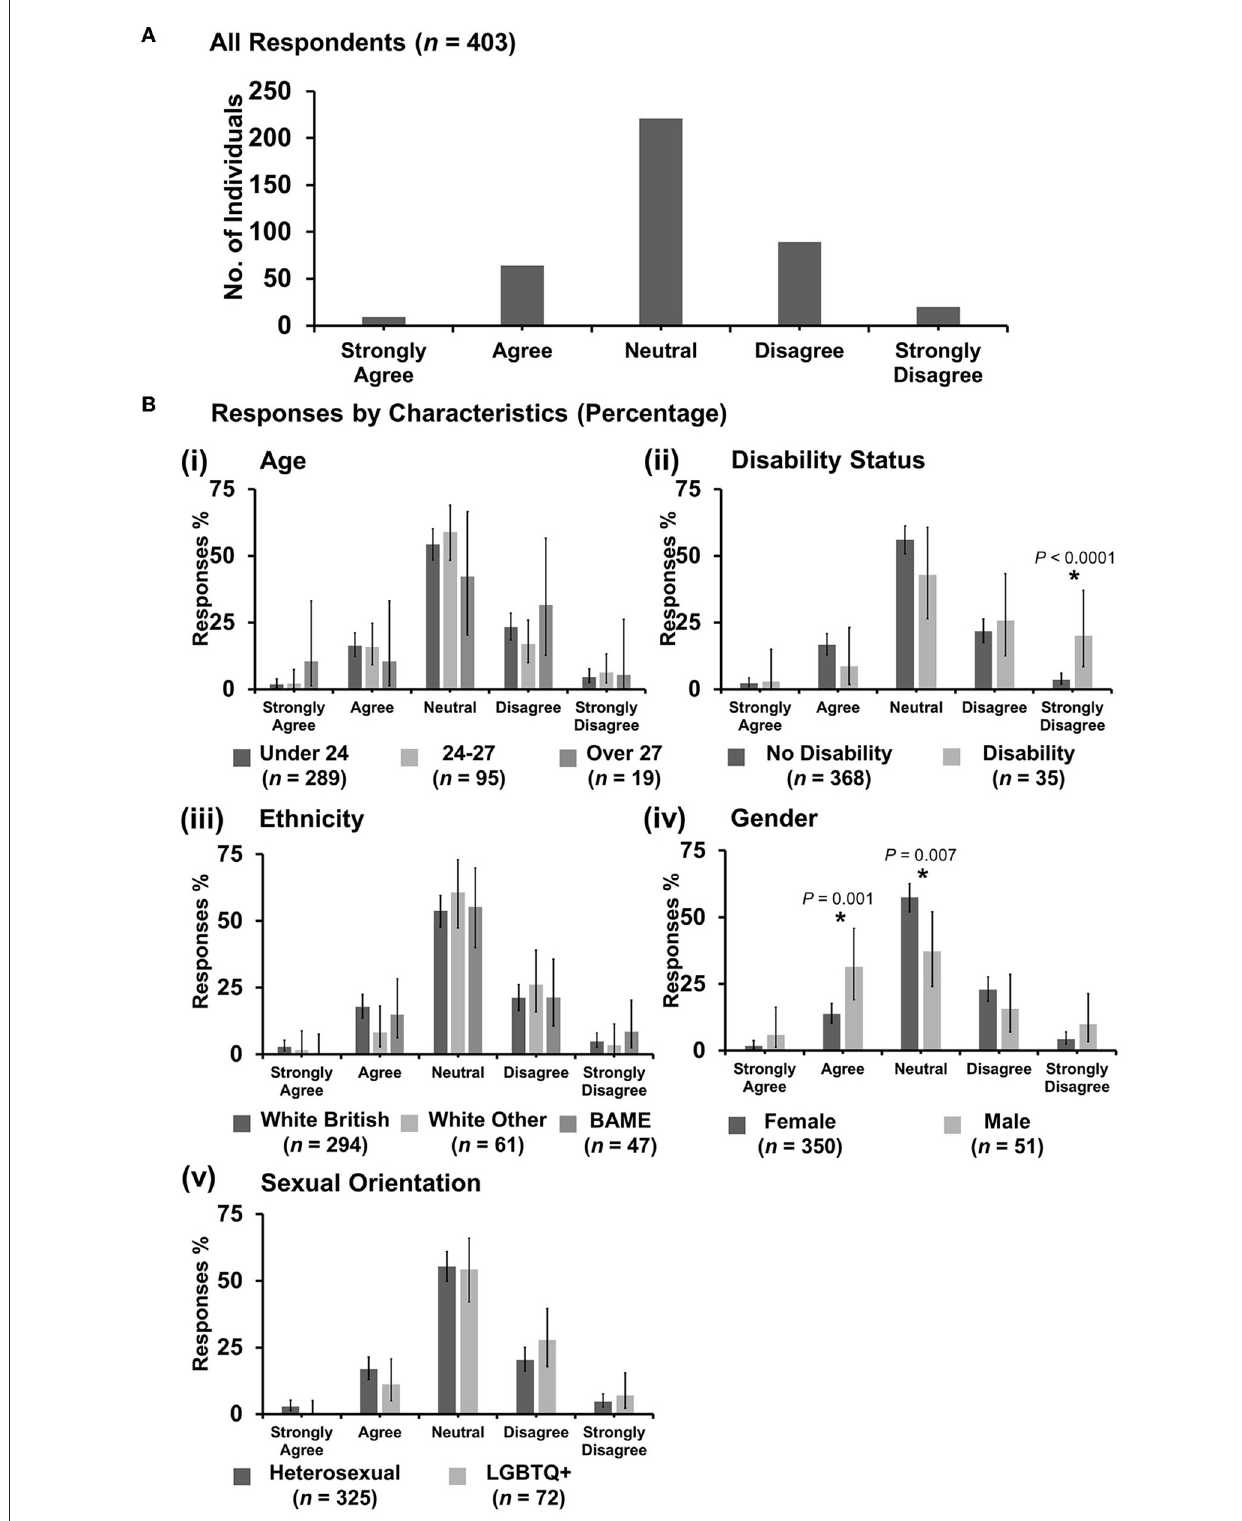
FIGURE6 Likert scale selections for the statement: professional bodies such as RCVS/BVA/AVS/Vet schools are doing enough to tackle discrimination. (A) Bar graph demonstrating the number of respondents selecting each Likert scale response. [ (B) i–v] Bar graphs demonstrating by percentage proportion the number of responses in each Likert category by the group under the demographic categories of age, disability status, ethnicity, gender, and sexual orientation. Error bars represent 95% confidence intervals calculated by the Binomial “Exact” method. Statistical significance was determined by Pearson’s chi-squared test of association between respondent’s group under category and Likert scale selection. * P <